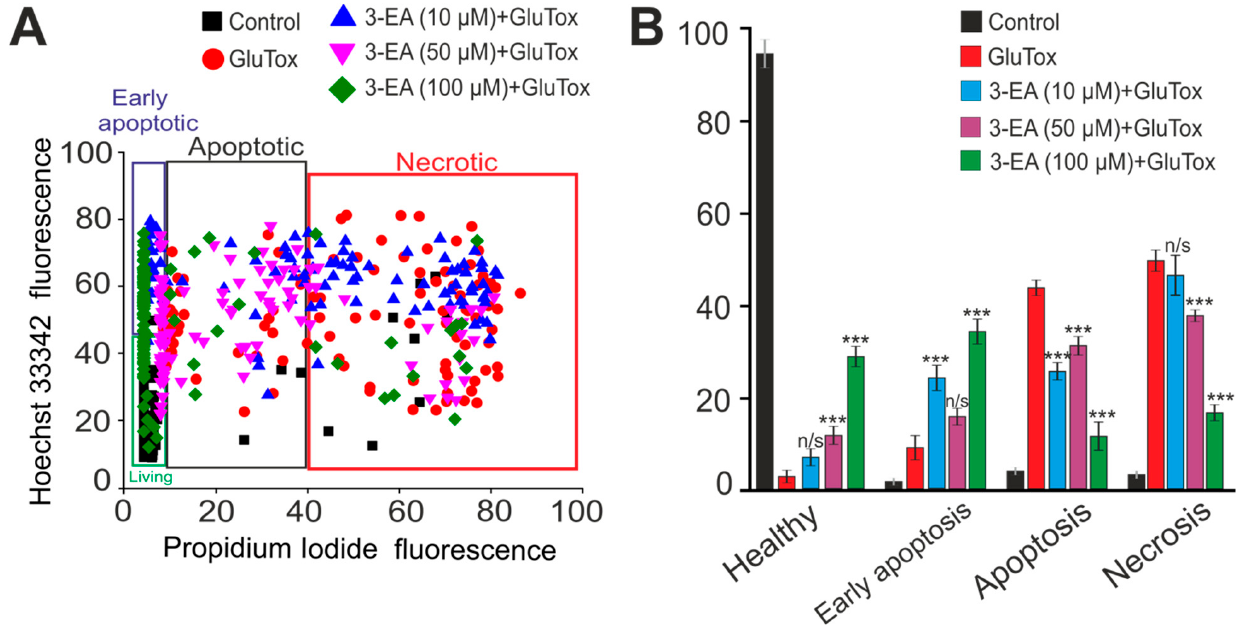
Figure 3. An effect of 24 h preincubation of the cortex cells with various concentrations of 3-EA on the viability of the cells during 24 h glutamate excitotoxicity (GluTox): ( A ) Cytogram showing the viability of cerebral cortex cells (horizontal axis–propidium iodide fluorescence intensity; vertical axis–Hoechst 33342 fluorescence intensity). Cells were stained with probes 24 h after GluTox outbreak. ( B ) An effect of 24 h preincubation of the cortex cells with various concentrations of 3-EA on the induction of necrosis and apoptosis with GluTox: the results are presented as Mean ± SD. Number of cell cultures = 3; number of coverslips with cells for each sample = 5; n/s-data are unreliable ( p > 0.05), *** p < 0.001 when comparing experimental groups with GluTox (ANOVA and Tukey’s post-hoc test).